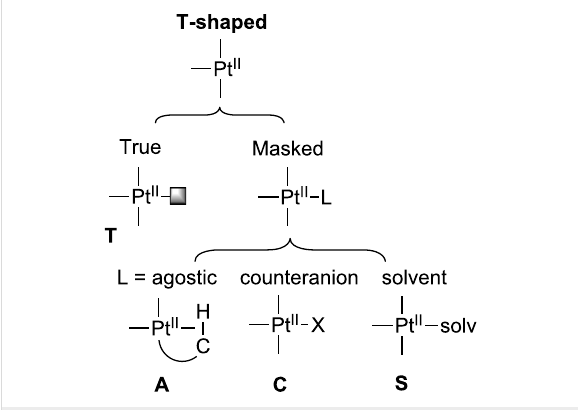
Figure 5: Hydride, boryl and borylene true T-shaped Pt(II) complexes. [Pt(B(Fc)Br)(PCy 3 ) 2 ] + T2a (Fc = ferrocenyl; Cy =